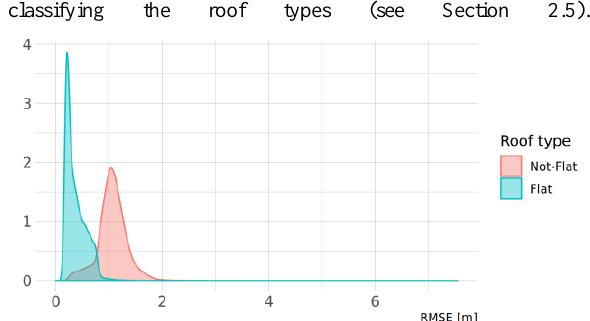
Figure 9. Distribution of RMSE of the geometric difference between the point cloud and building model for all the buildings in the Netherlands.